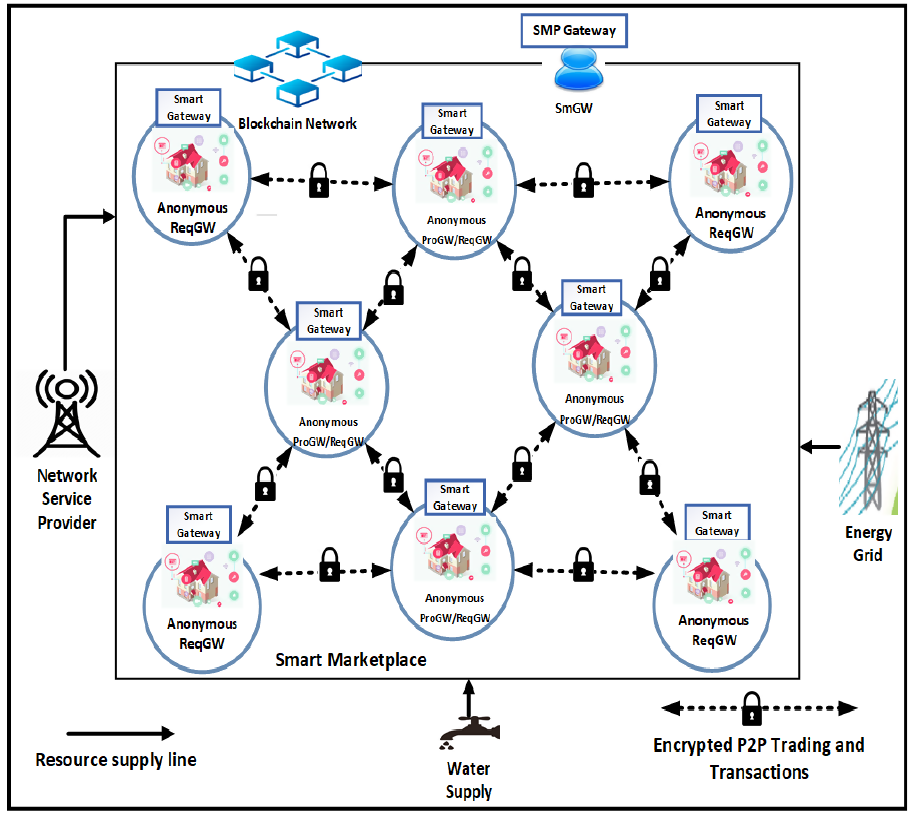
Figure 1. System